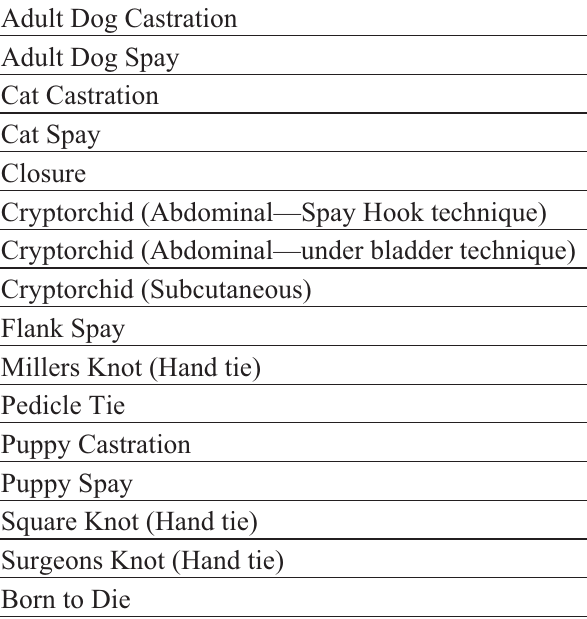
Table 1. Surgical Instructional Videos. Students review videos of all surgical techniques and procedures prior to performing surgery on the mobile veterinary